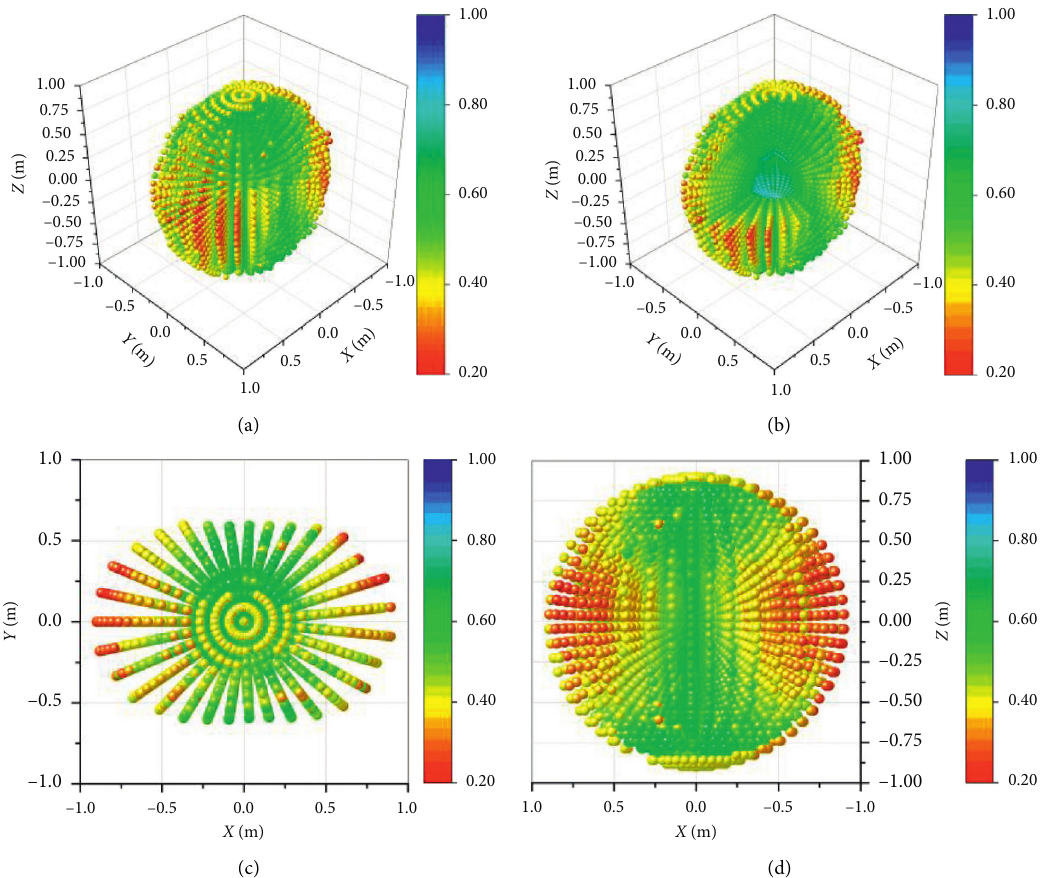
Figure 8: TOSM of the system in the workspace under the speed condition. (a) Axonometric view. (b) Section view. (c) X - Y plane. (d) X - Z